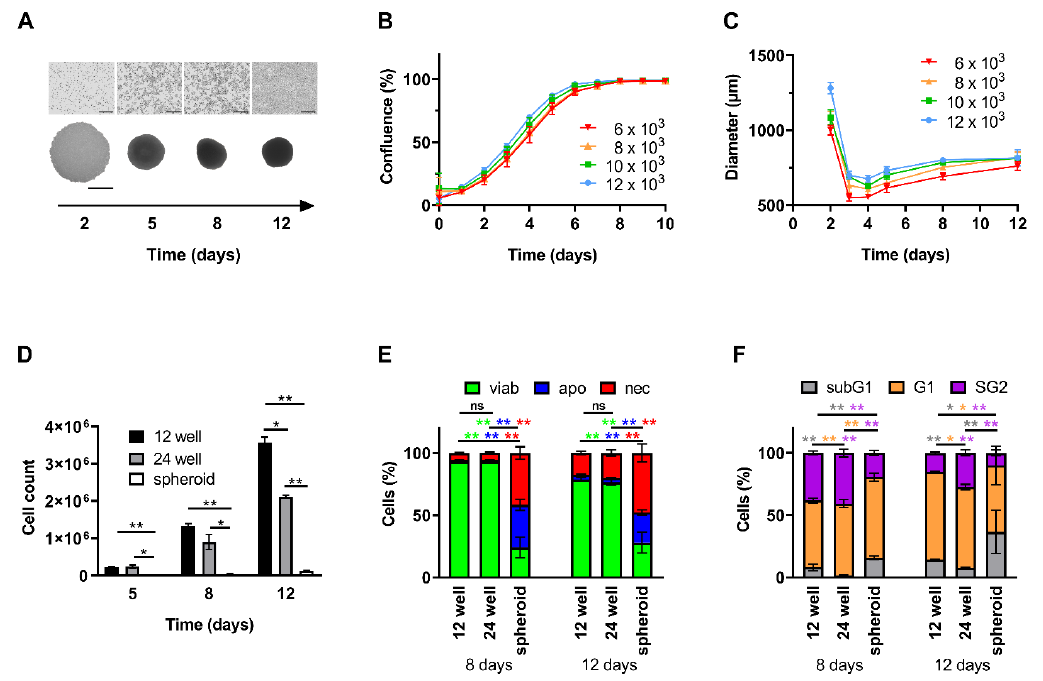
Figure 1. Proliferation, cell cycle and viability of cells cultured as monolayers or spheroids. HT-29 cells were seeded as monolayers (12-well plates) or spheroids (96-well plates). ( A ) Brightfield microscopy shown for 1.2 · 10 4 cells initially seeded. Top row: monolayer cells; bottom row: spheroids, scale bars refer to 400 µ m. ( B ) Confluence of monolayer cells was calculated according to brightfield pictures from IncuCyte ® system. ( C ) Diameters of spheroids were measured and calculated by ImageJ Software. ( D ) Absolute cell count was determined from single cell suspensions by a MUSE Cell Analyzer. ( E ) Viable, apoptotic, and necrotic cells were determined by AnnexinA5-FITC/propidium iodide (Ax/PI) staining in flow cytometry. Ax - PI - cells are considered viable, Ax + PI - apoptotic and PI + necrotic. ( F ) Cell cycle distribution and DNA degradation were determined with propidium iodide/Triton X-100 staining showing the amount of degraded DNA (subG1 phase), diploid DNA (G1 phase), and double diploid DNA (synthesis/G2 phase). Experiments were performed 3–4 times at least in triplicates. Shown are the mean values of ≥9 wells (2D cell culture) or quadruplicates of 3 pooled spheroids (3D cell culture) with standard deviations (* p ≤ 0.05; ** p ≤ 0.01 Student`s t -test).